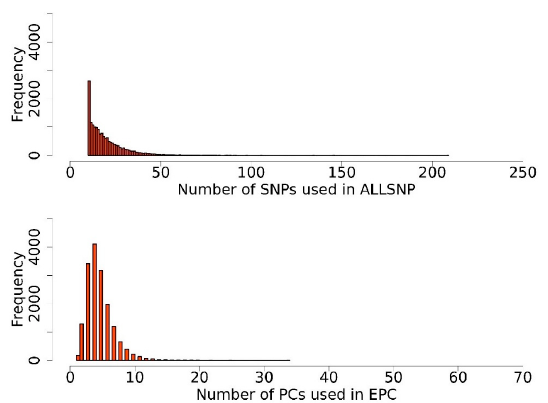
Figure 1. Distribution in numbers of SNPs and PCs forming gene blocks. The upper picture is the distribution in numbers of SNPs forming gene blocks by ALLSNP method. The lower picture shows the distribution in the numbers of PCs selected from each gene by EPC method.